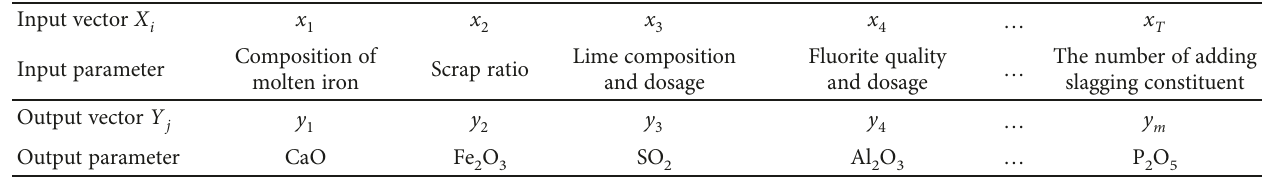
Table 1: Input and output indicators of CNN.